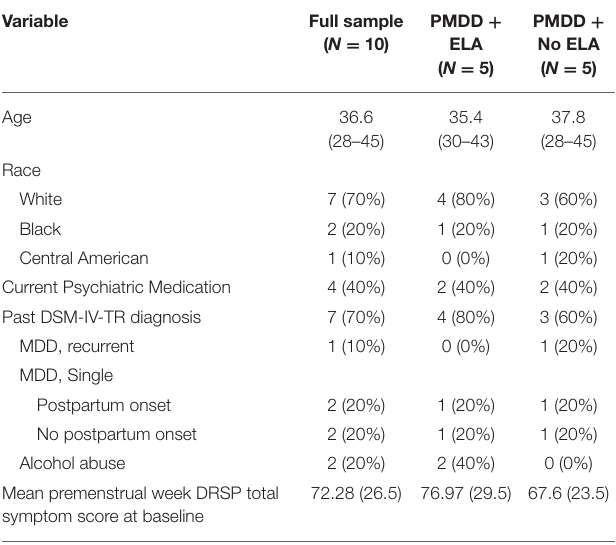
TABLE 1 | Sample descriptive information by abuse